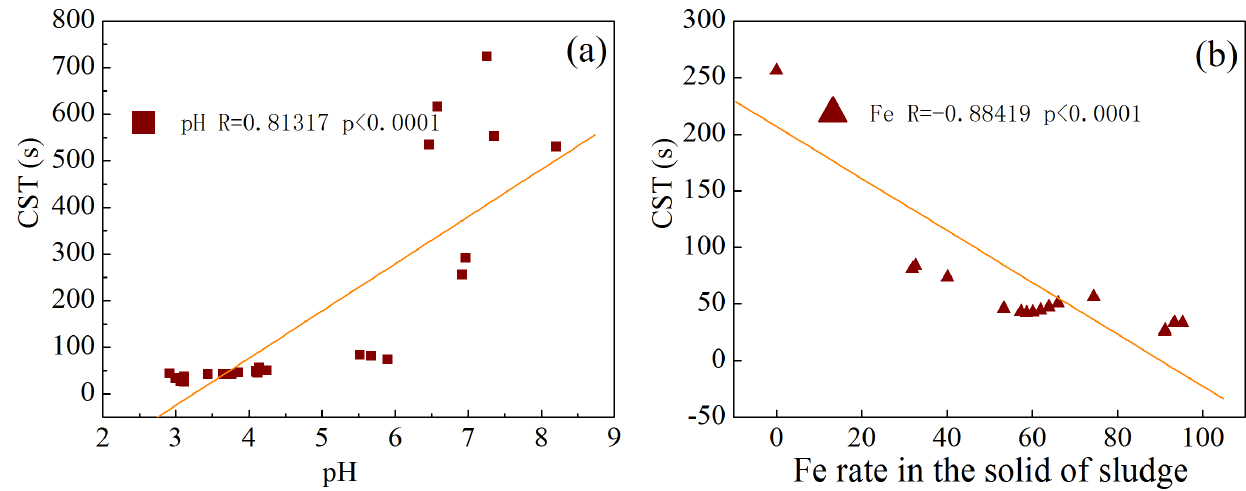
Figure 6. Pearson correlations between sludge CST and sludge pH (a), and the distribution ratio of Fe in the solid phase to the aqueous phase of sludge (b) during sludge bioleaching process.